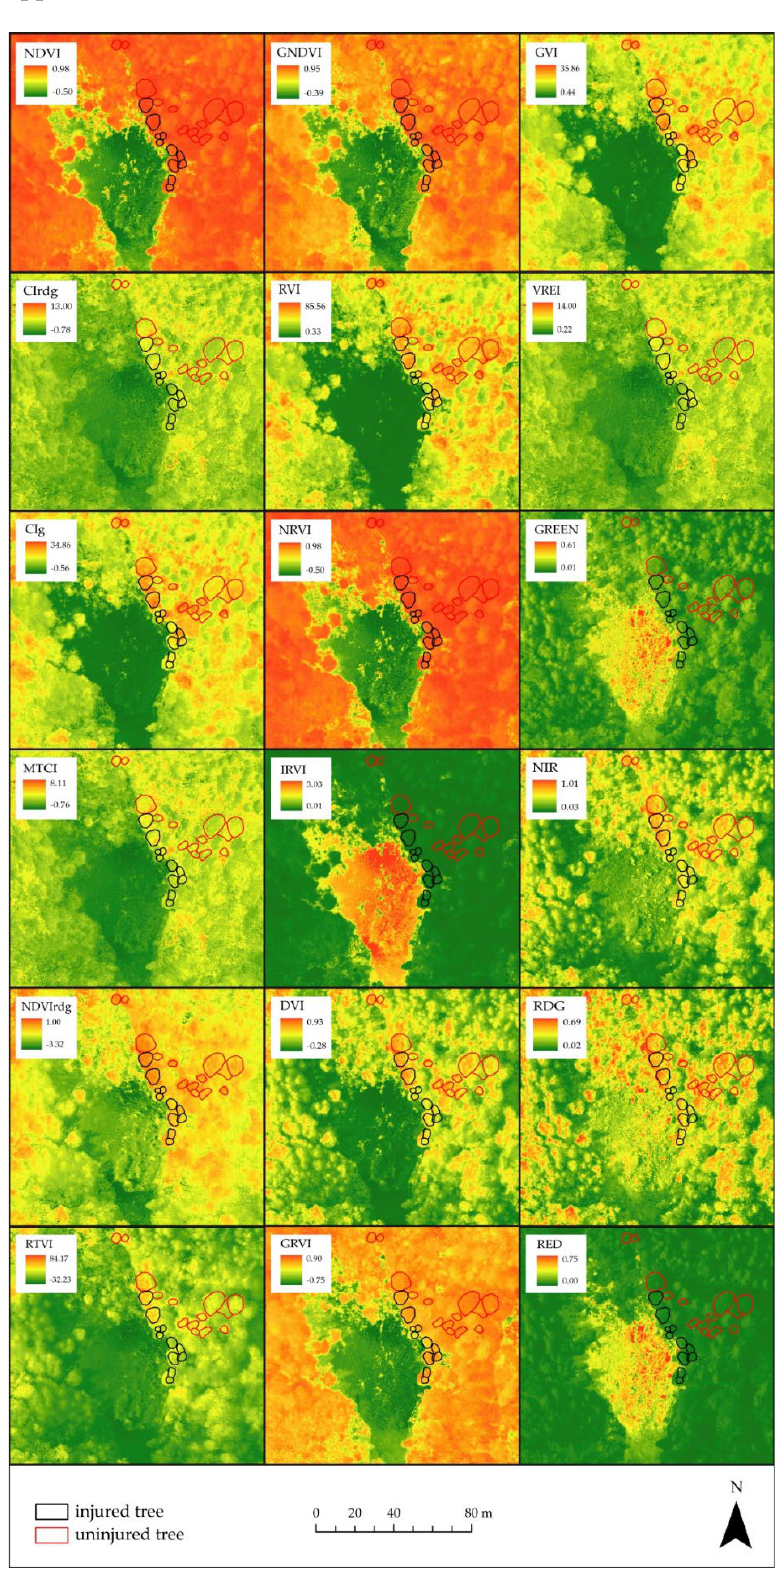
Figure A3. The maps of all vegetation indices (VIs) and individual spectral bands for the Kekec site (3 July 2018).